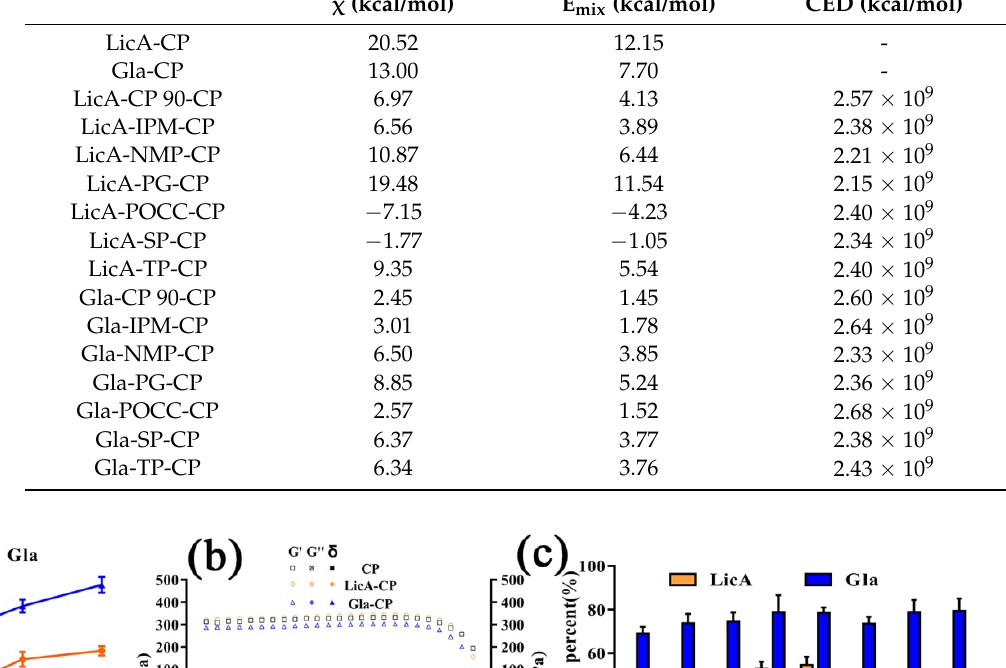
Table 2. The E mix , χ , and CED of different Gla (LicA)–enhancers–CP systems.